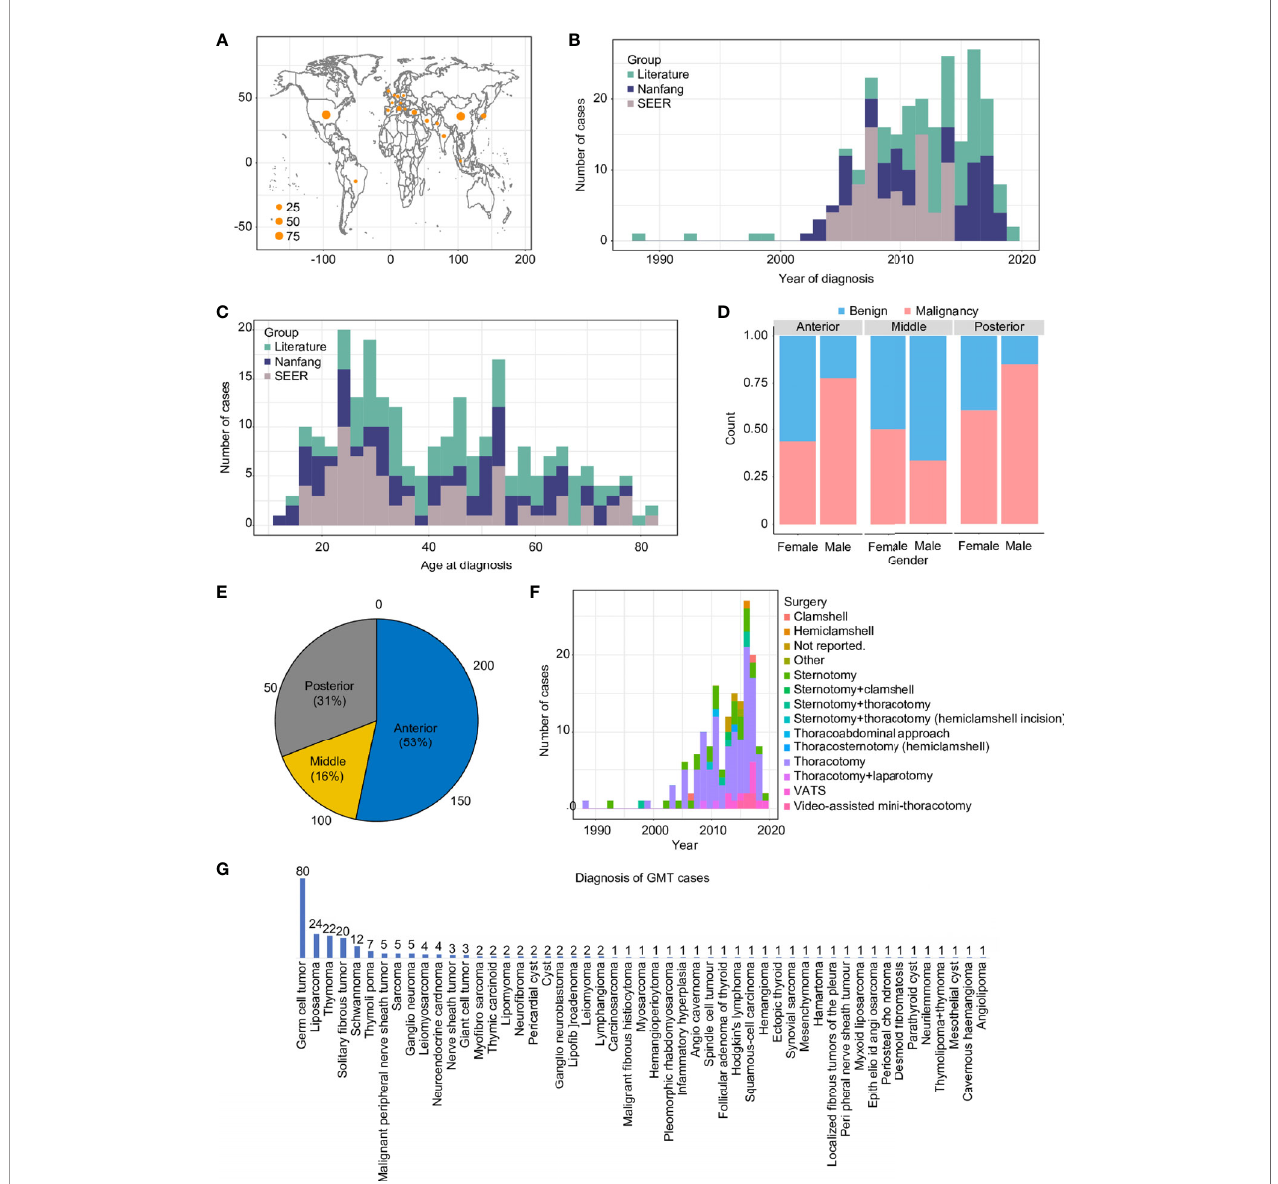
FIGURE 1 | Overview of GMT resections from 1988 to 2019 in three cohorts. GMT distribution in countries around the world (A) , in reports from 1988 to 2019 (B) , by age (C) , by sex (D) , by mediastinum location (E) , by surgical approach (F) , and by pathological diagnosis (G)